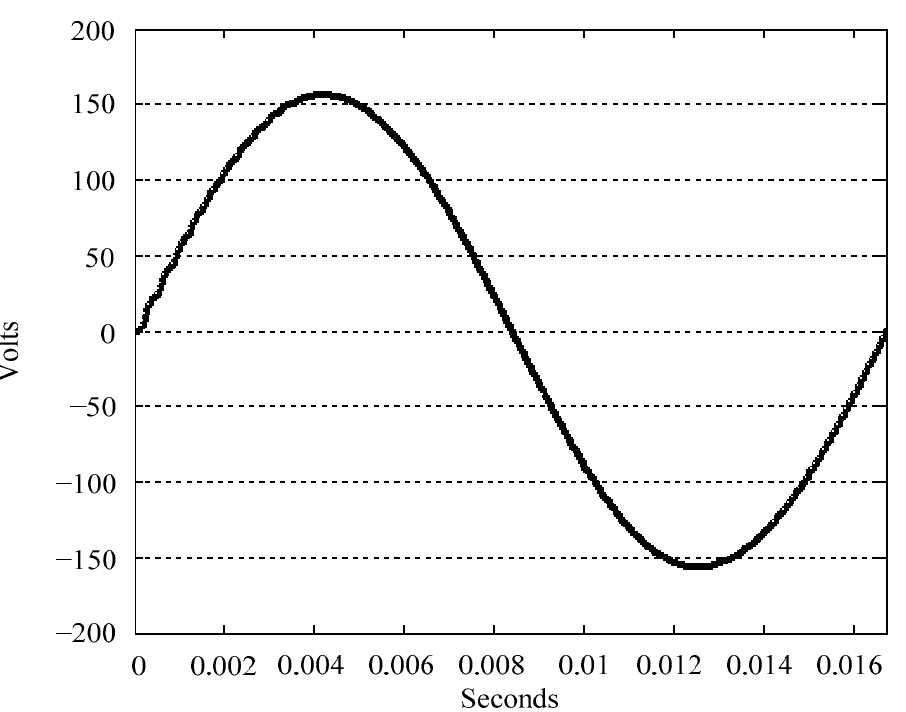
Figure 6. Simulated output voltage with the conventional SMC under LC parametric variations.